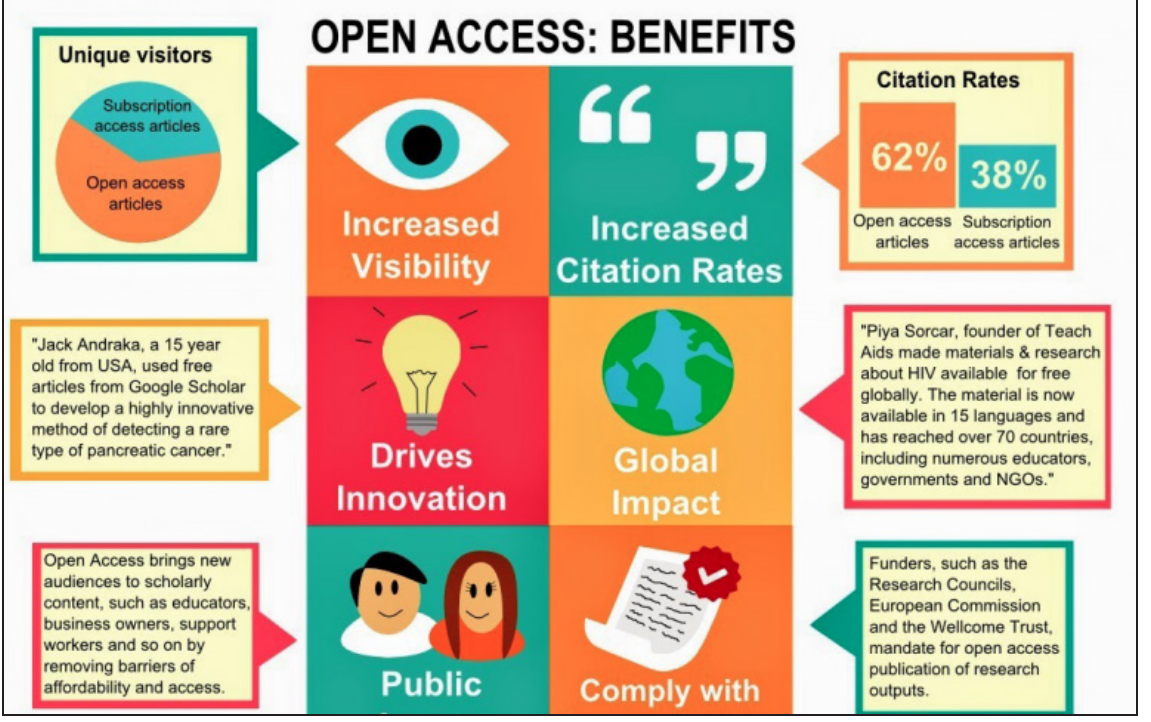
Fig. 17. Open Access benefits, from Aston University Library Services (available from